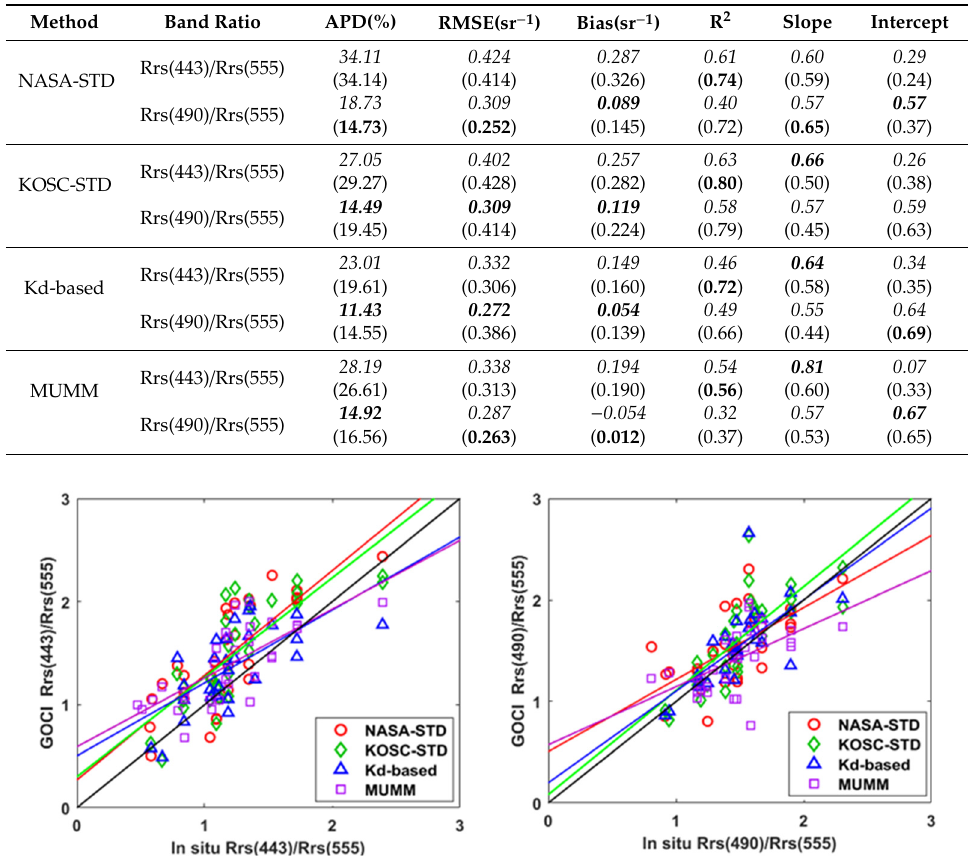
Figure6. ScatterplotsofbandratiosRrs(443) / Rrs(555)andRrs(490) / Rrs(555)betweentheGOCI-retrieved Figure 6. Scatterplots of band ratios Rrs(443)/Rrs(555) and Rrs(490)/Rrs(555) between the and the in situ ratios at 02:16, 03:16, and 04:16 UTC within a ± 3 h match-up time-window. Symbols are GOCI-retrieved and the in situ ratios at 02:16, 03:16, and 04:16 UTC within a ±3 h match-up the same as described in Figure time-window. Symbols are the same as described in Figure 4.